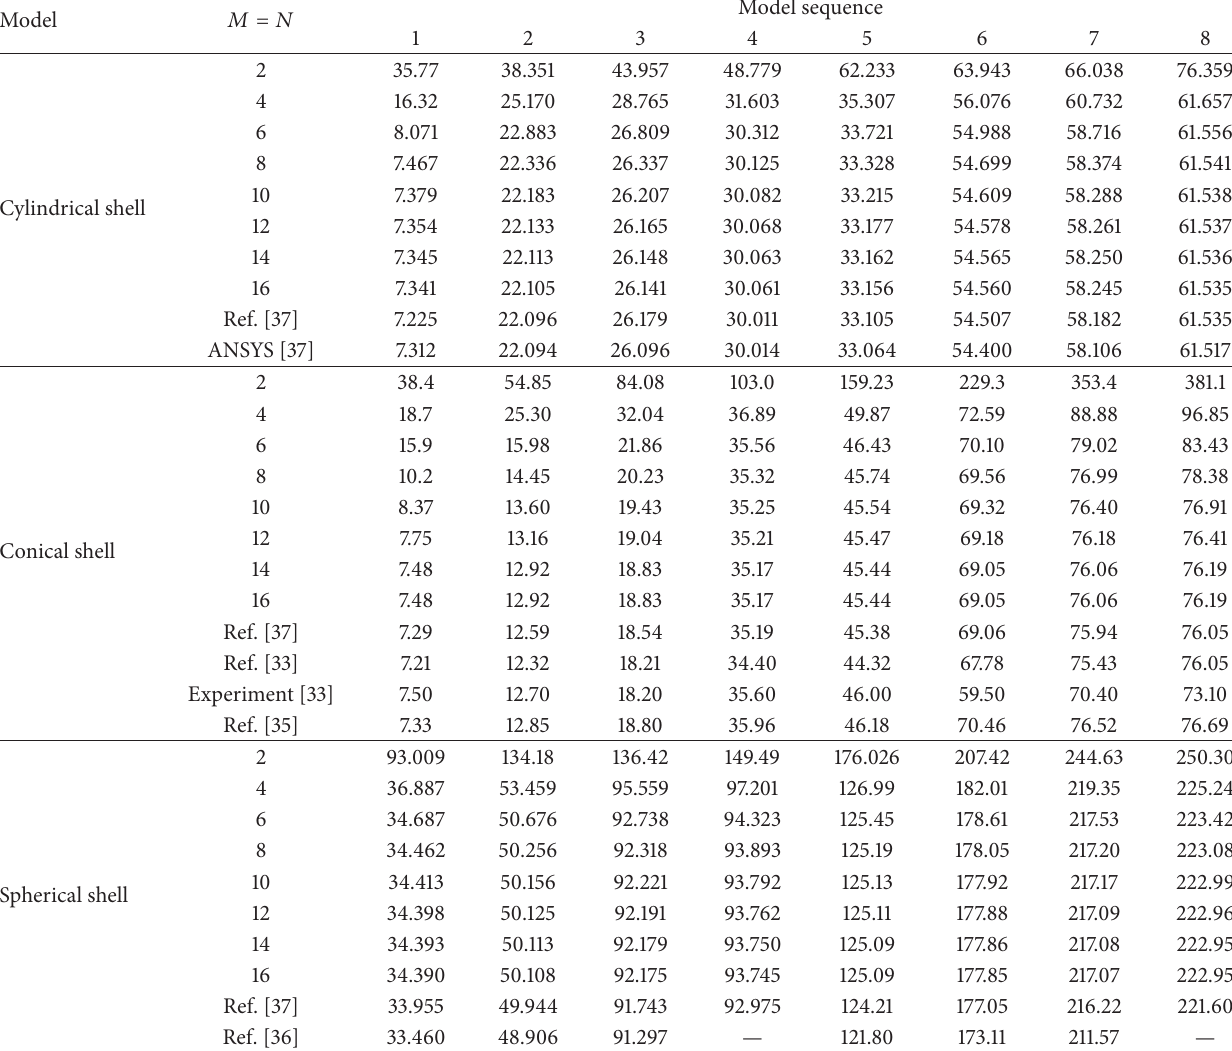
Table 1: Comparison and convergence of the first eight natural frequencies (Hz) for three open shells with F-F-F-F boundary condition. Model